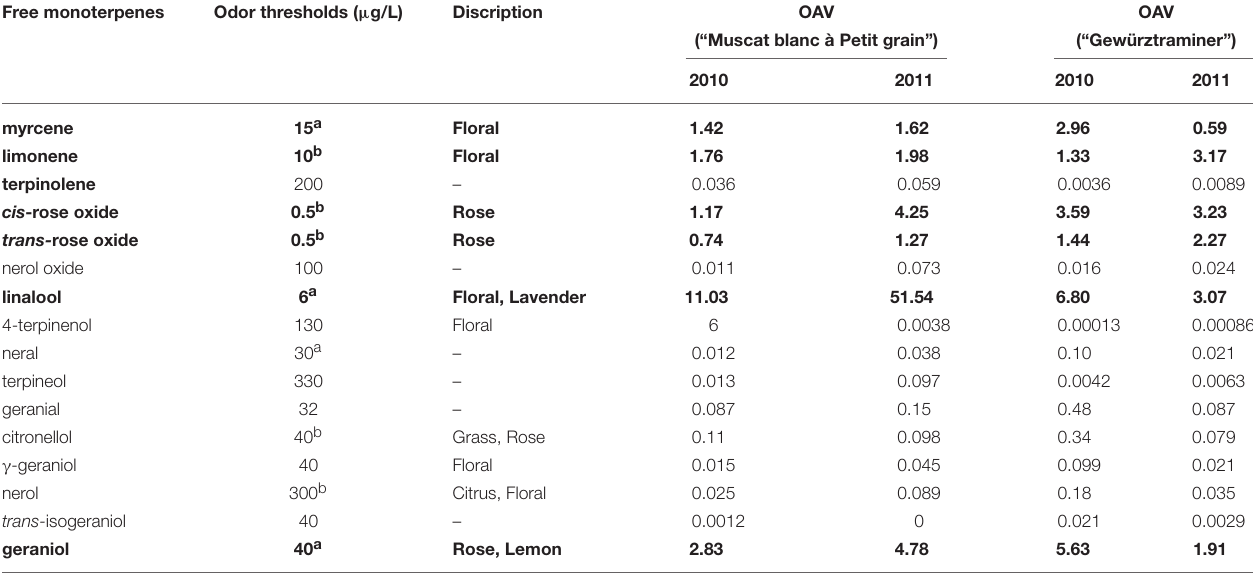
TABLE 2 | Odor thresholds and odor activity values (OAVs) of free monoterpenes in two Vitis vinifera varieties at harvest. Free